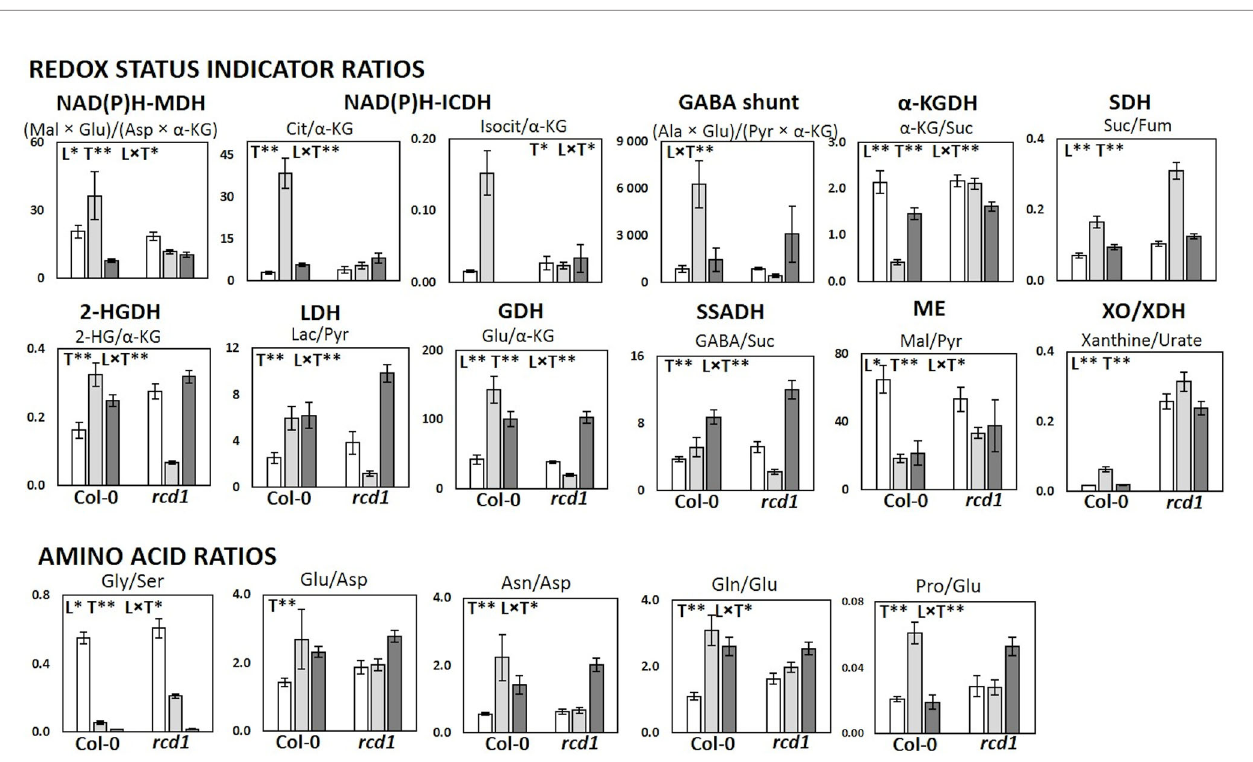
FIGURE 5 | Metabolic and redox status indicator ratios in Col-0 and rcd1 in control light conditions (white), after MV exposure (light gray) and after extended darkness (dark gray). Statistically signi fi cant effects of plant lines (L), treatment (T) and line × treatment interaction (L × T) on metabolite ratios were tested with two- way ANOVA (p < 0.05*, p < 0.01**). Data are mean ± SE, n = 3 – 8.